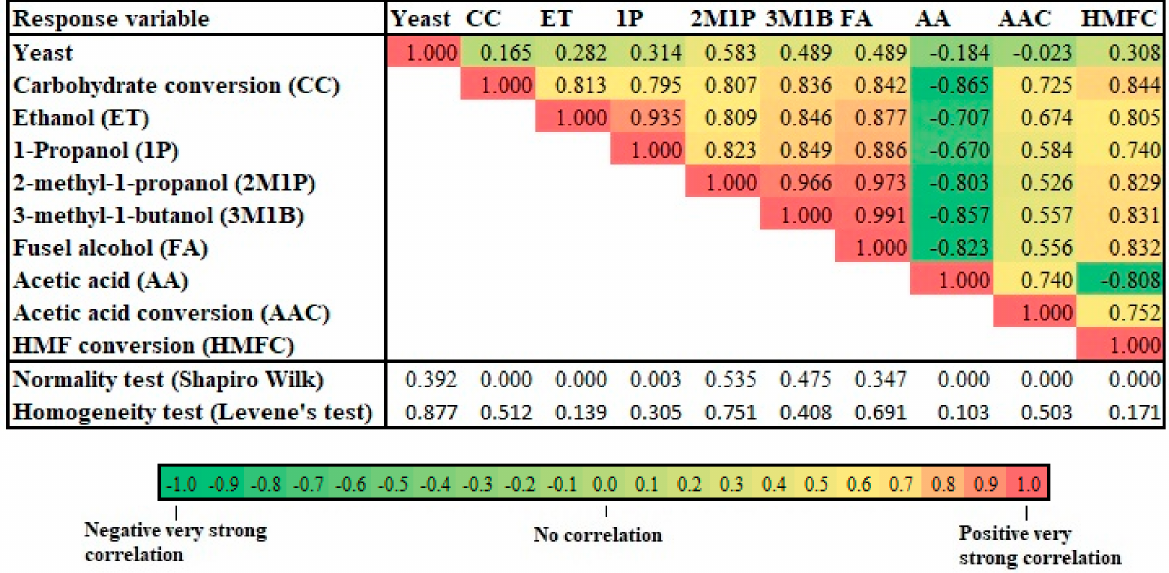
Figure 2. Spearman correlation coefficient matrix ( p < 0.05) among the response variables tested during the fermentation of sugarcane press-mud, as well as p values for the normality test and homogeneity